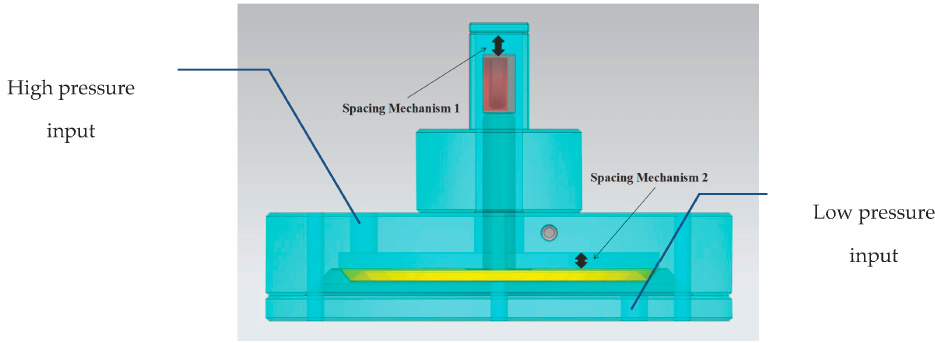
Figure 5. The position limiting mechanism of the sensor.